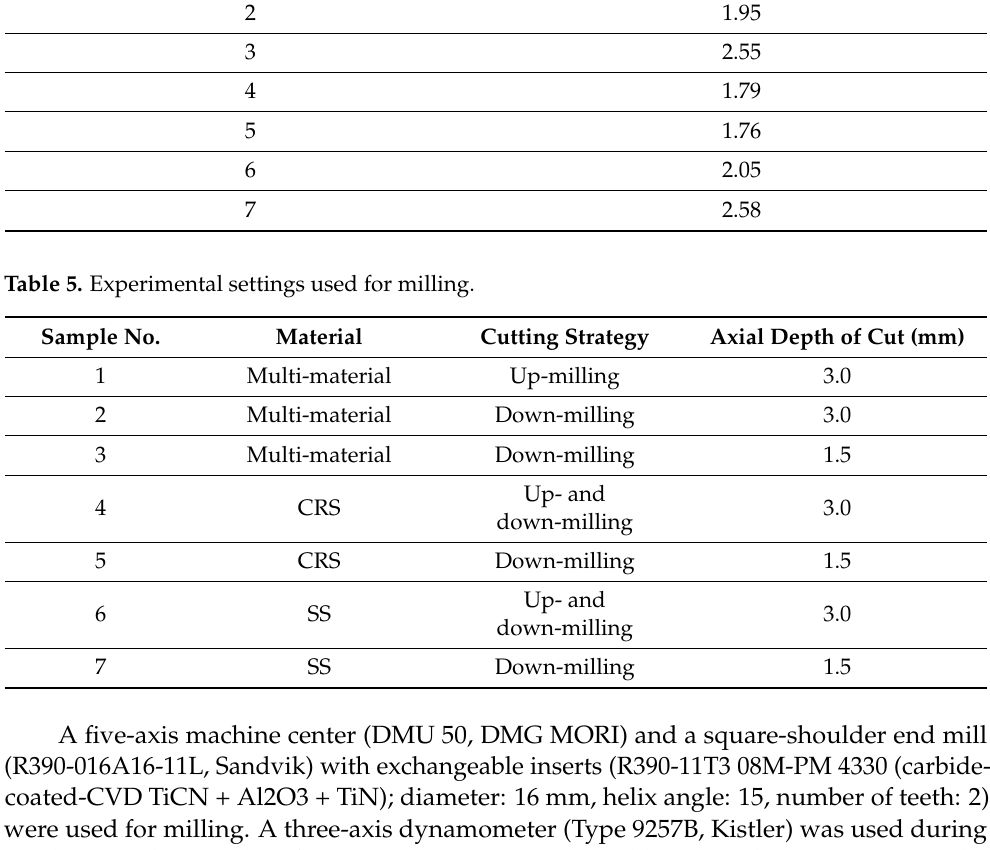
Table 4. Machining allowances calculated based on the 3D scanning results.